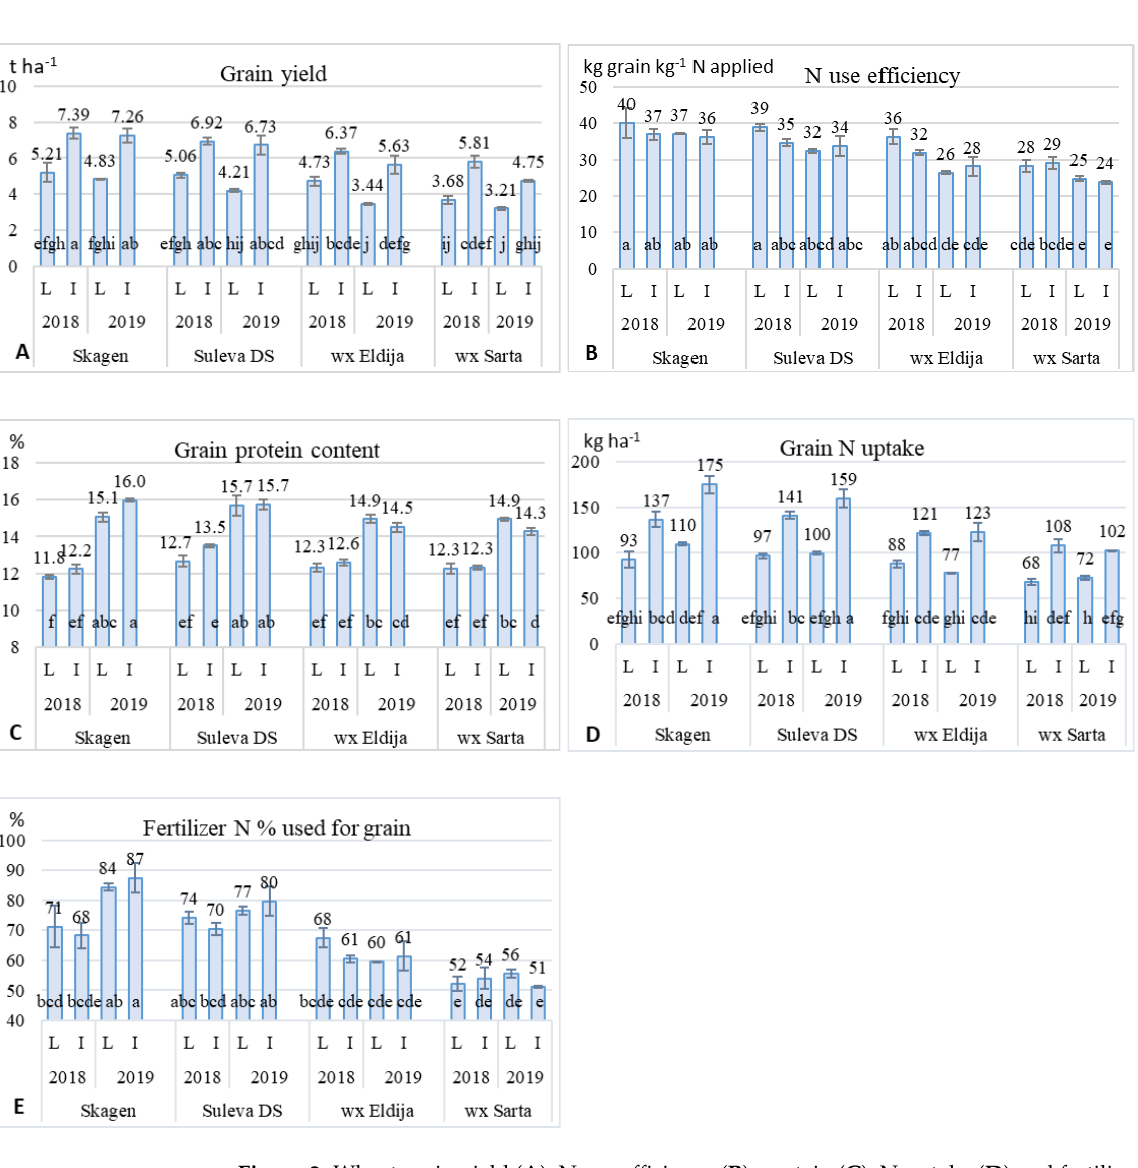
Figure 2. Wheat grain yield ( A ), N use efficiency ( B ), protein ( C ), N uptake ( D ) and fertilizer N used for grain ( E ) distribution through non-waxy (‘Skagen’, ‘Suleva DS’) and waxy (‘Eldija’, ‘Sarta’) winter wheat cultivars grown under different farming systems (L—low-input, I—intensive) in two cropping seasons. Values in columns followed by the same letter are not significantly different at p <